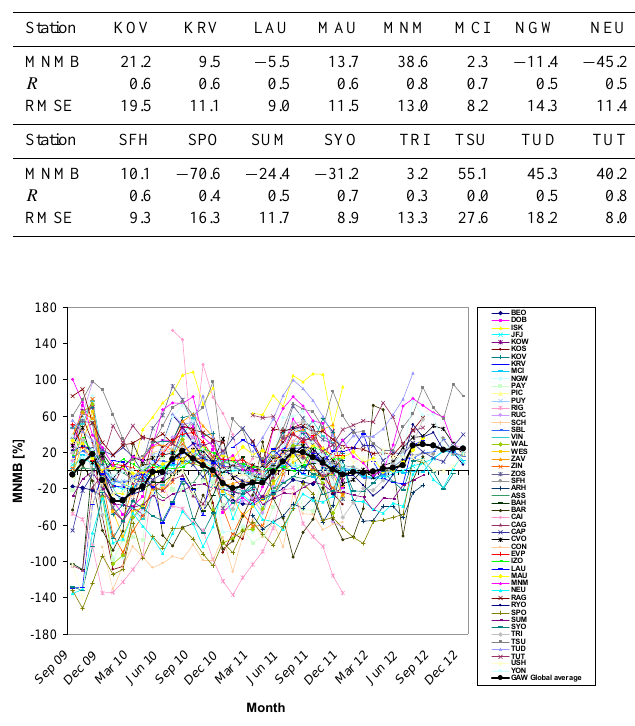
Figure 5. Root mean square error (RMSE) in ppb derived from the evaluation of the MACC_osuite with GAW O 3 surface observations during the period September 2009 to December 2012 (black line: global average of 50 GAW stations. Multi-coloured lines: individual station results; see legend to the